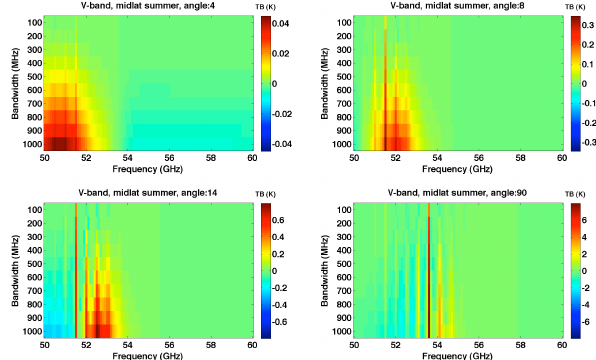
Fig. 8. The errors associated to the channel bandwidth effect in dif- Figure 8. The errors associated to the channel bandwidth effect in differential TB for V-band 5 ferential TB for V-band frequencies using the mid-latitude summer frequencies using the mid-latitude summer atmospheric profile. The TB differences are 6 atmospheric profile. The TB differences are defined as the TB cal- defined as the TB calculated from a forward model without bandwidth minus the TB 7 culated from a forward model without bandwidth minus the TB cal- culated from a forward model with calculated from a forward model with bandwidth. 8